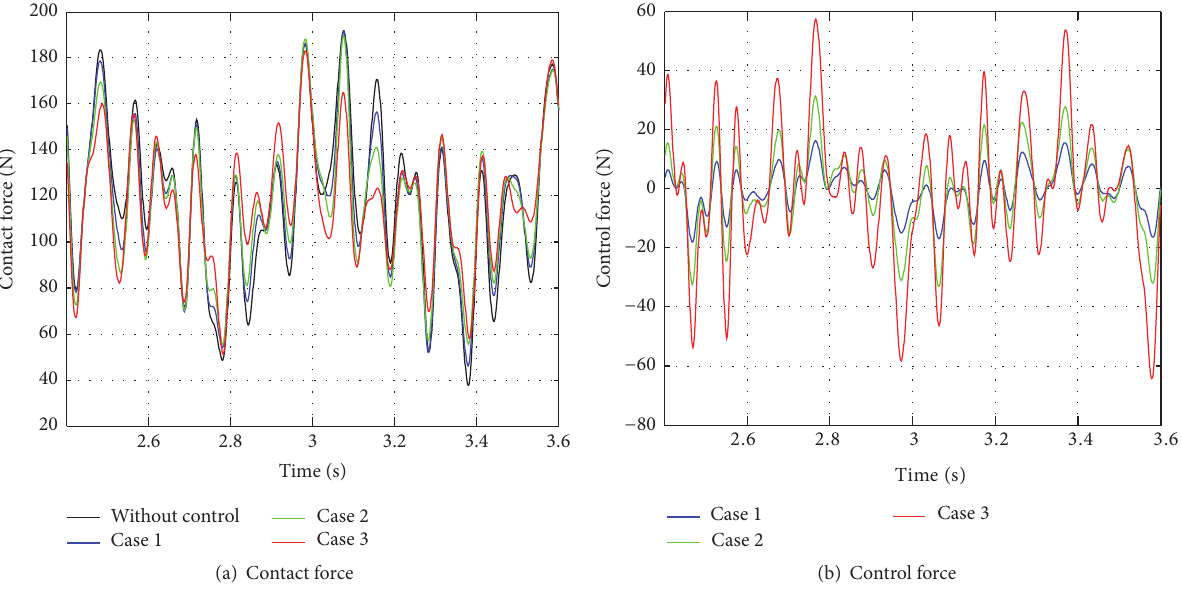
Figure 13: Contact force and control force with proportional switching law.